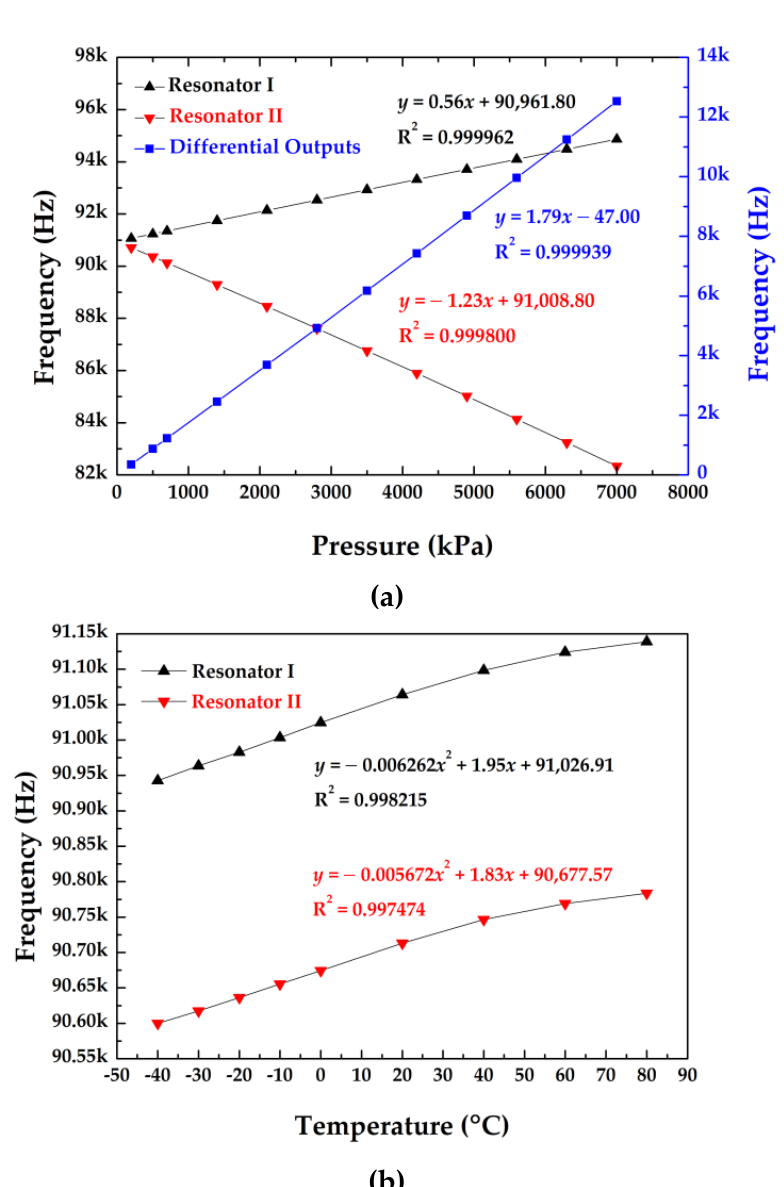
Figure 4. ( a ) The pressure–frequency curve of the developed sensor at 20 °C; ( b ) the temperature– frequency curve of the developed sensor under 100 kPa.